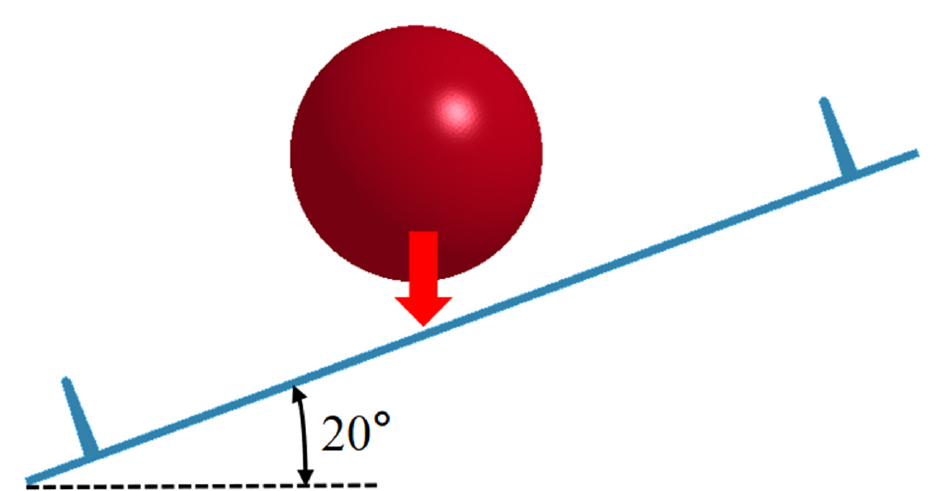
Figure 7. Condition 2 in the simulation environment.